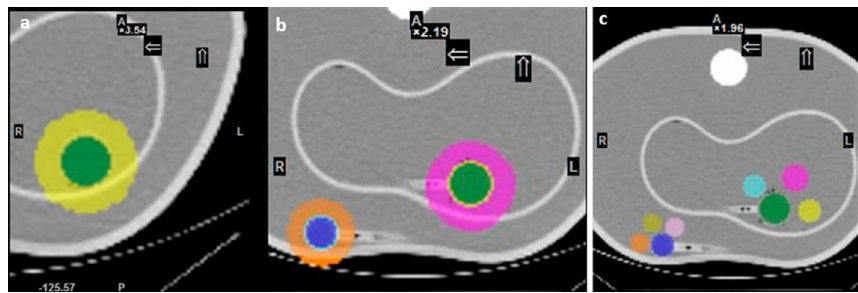
Fig. 3 Delineation methods for anthropomorphic phantoms. In methods a 1 and b 2, the inner VOI (green or blue) represents the sphere VOI, while the outer thick ring delineates the surrounding background VOI. In method 2 ( b ), the thin middle ring is used to separate both VOIs to prevent spill in/out from sphere to background. With method 3 ( c ), random background spherical VOIs are placed around the sphere